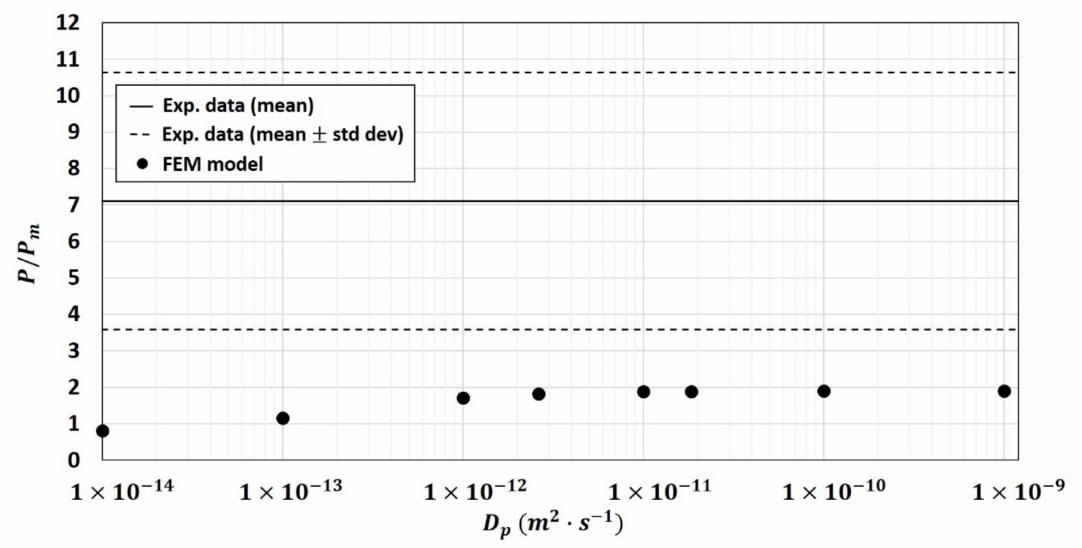
Figure 7. Effect of particle diffusivity D p on numerical relative permeability P / P m (calculated using the 2-phase model) into the composite of ϕ p = 19.52 % v / v (hypothesis tested on 10 structures).